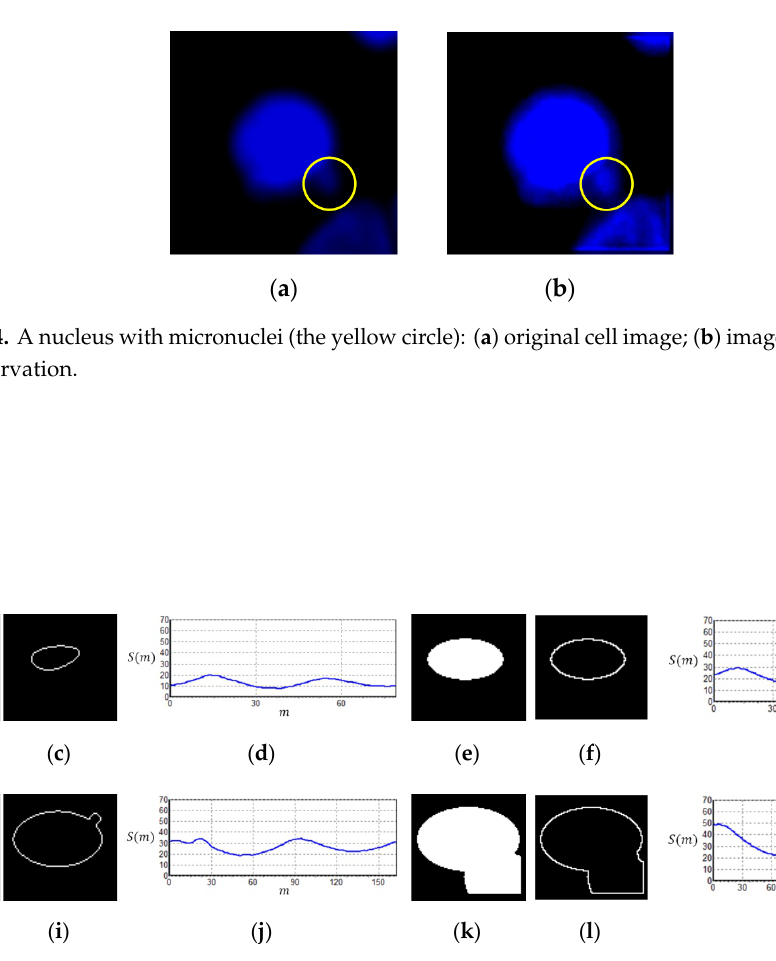
Figure 7. Micronucleus detection of real cell nuclei images: ( a1 ), ( a2 ) contour of cell regions; ( b1 ), ( b2 ) signature curves; ( c1 ), ( c2 ) short window energy curve; ( d1 ), ( d2 ) short window energy curves by screening sensitivity ( μ = 4). 𝛿𝛿 ( 𝑚𝑚 ) = ∑